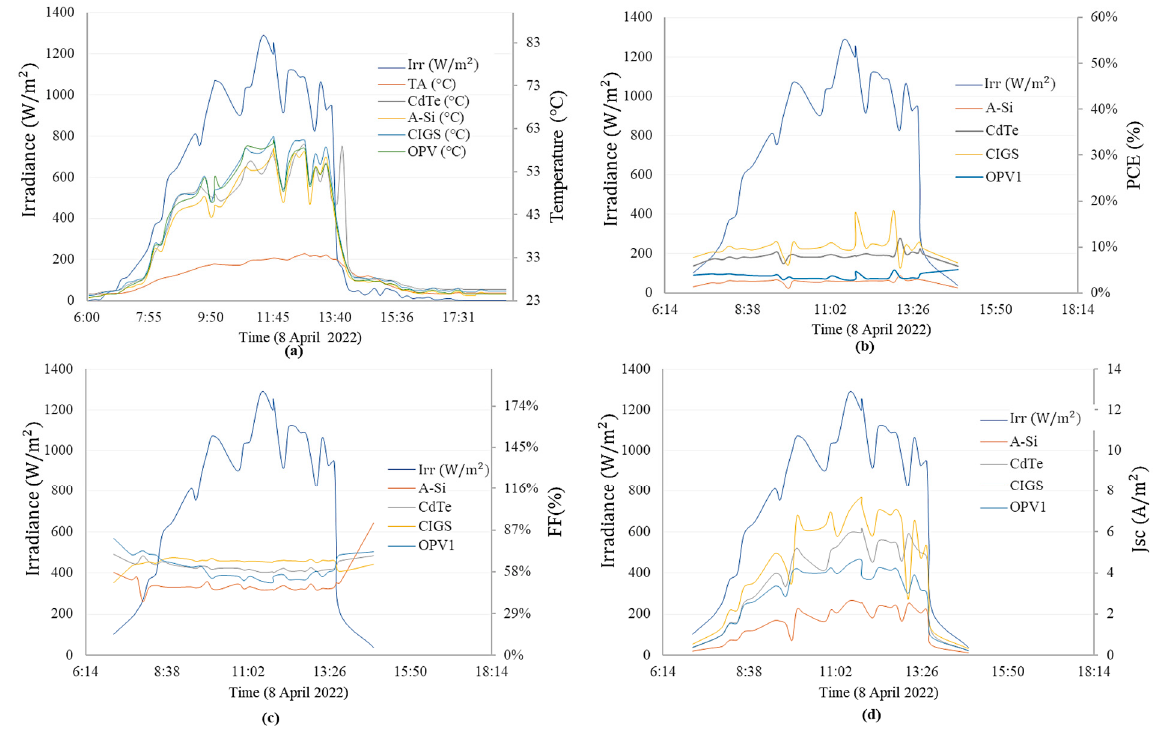
Figure 10. Diurnal PV/OPV technologies performance in PVMS1 for a sunny day (8 April 2022). ( a ) Irr/Temp. vs. Time; ( b ) Irr/PCE vs. Time; ( c ) Irr/FF vs. Time, ( d ) Irr/Jsc vs. Time.